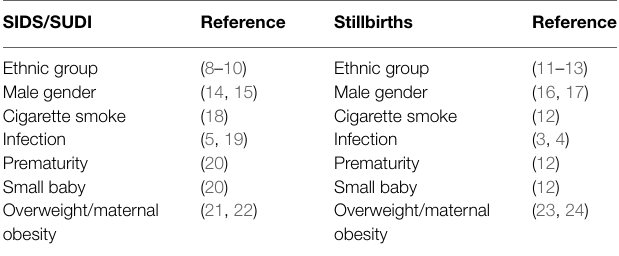
TABLE 1 | Comparison of risk factors for SIDS/SUDI and stillbirths